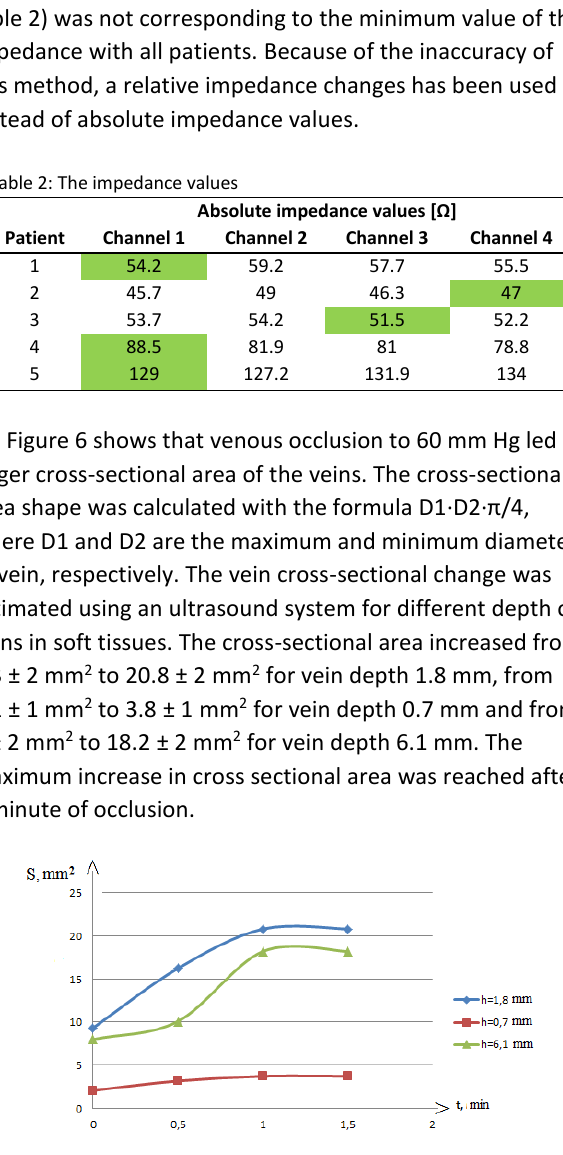
Fig. 6: The vein cross-sectional changes during